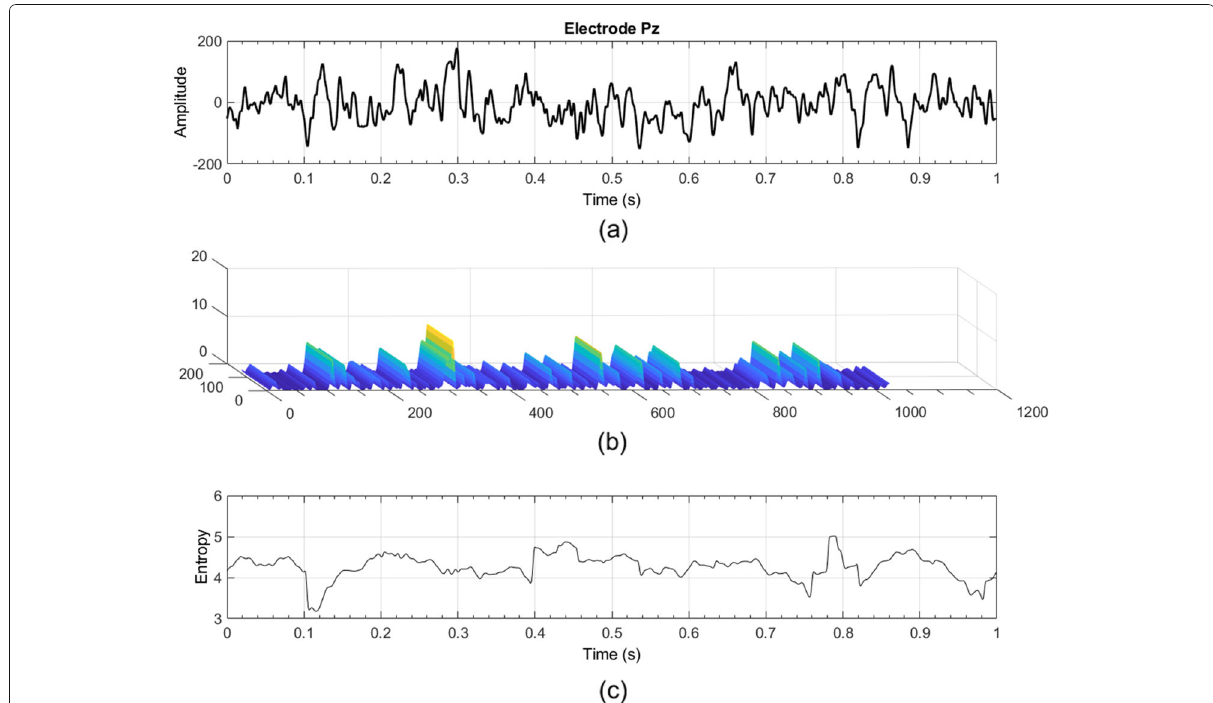
Fig. 7 Electrode Pz. a Time domain representation of ERP. b SPWVD time-frequency representation. c Short-term Rényi entropy of the distribution